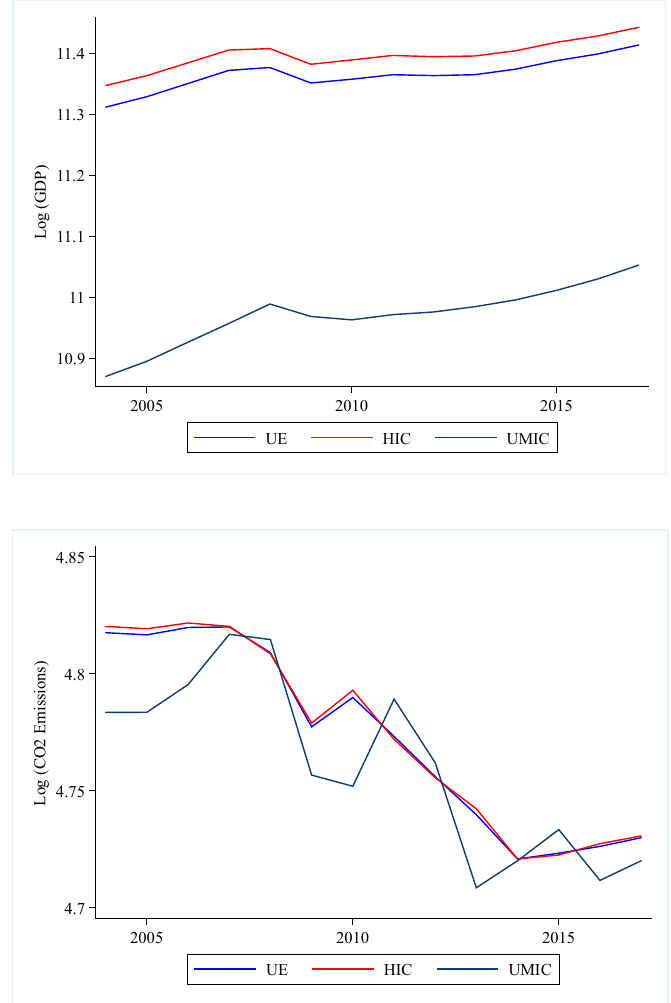
Figure 1. Evolution of gross domestic product (GDP) and CO 2 emissions. Source: own elaboration based on data from World Bank (WB) [63] and European Statistical Office (EUROSTAT) [64]. Table 1. Definition of variables.